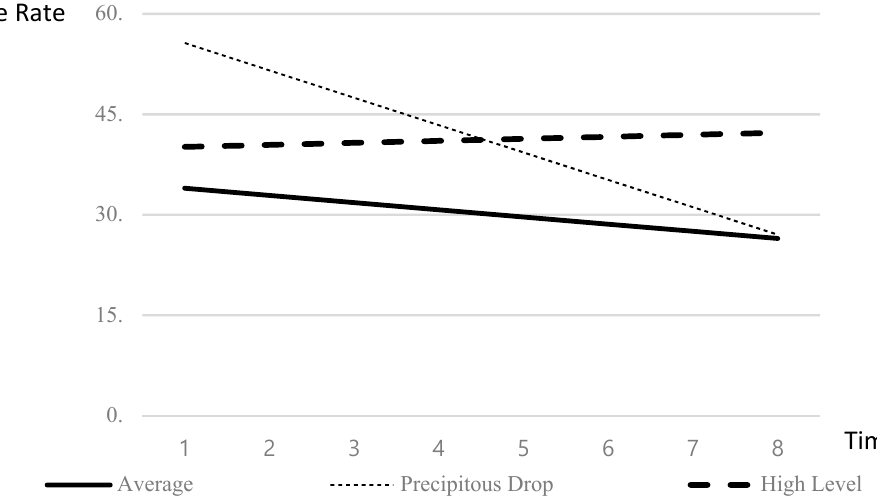
Figure 1. Estimates of the Initial Value and the Rate of Change by Suicide Rate Change Pattern.